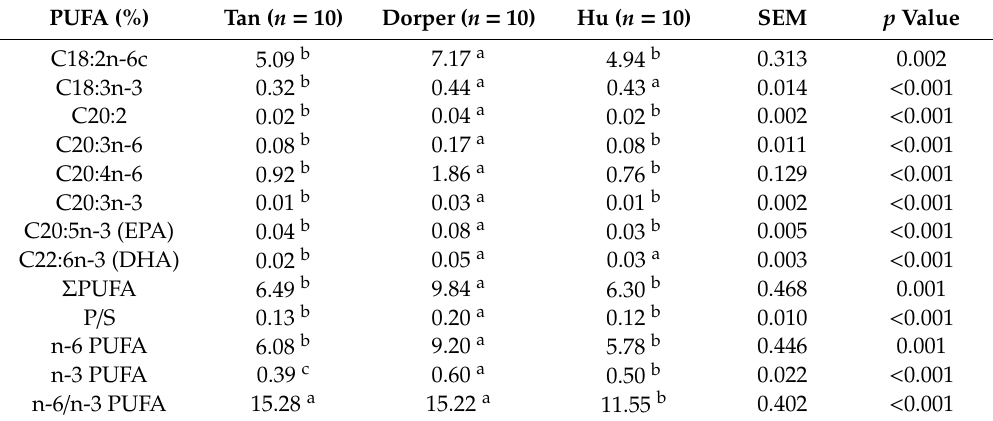
Table 5. E ff ect of breed on polyunsaturated fatty acid (%) of